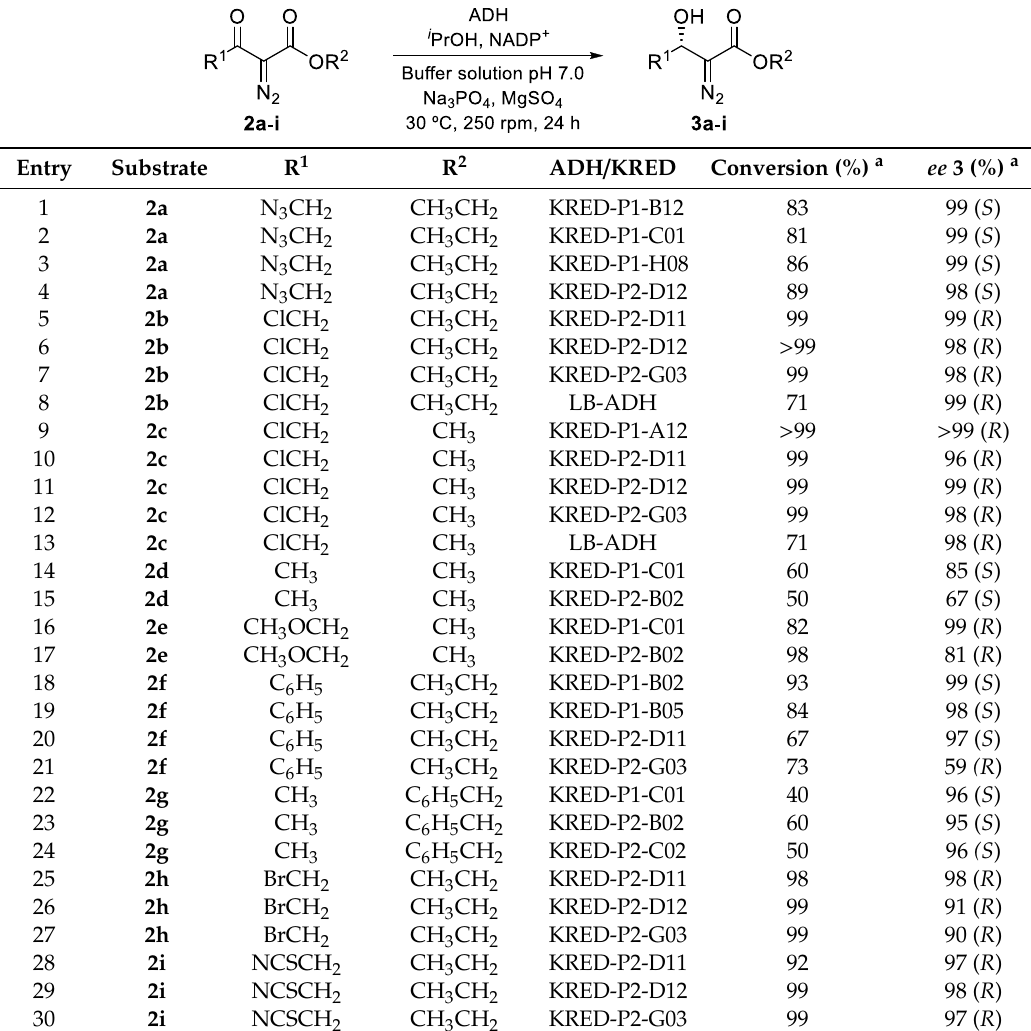
Table 3. Selected examples for the stereoselective bioreduction of α -diazo- β -keto esters 2a – i .